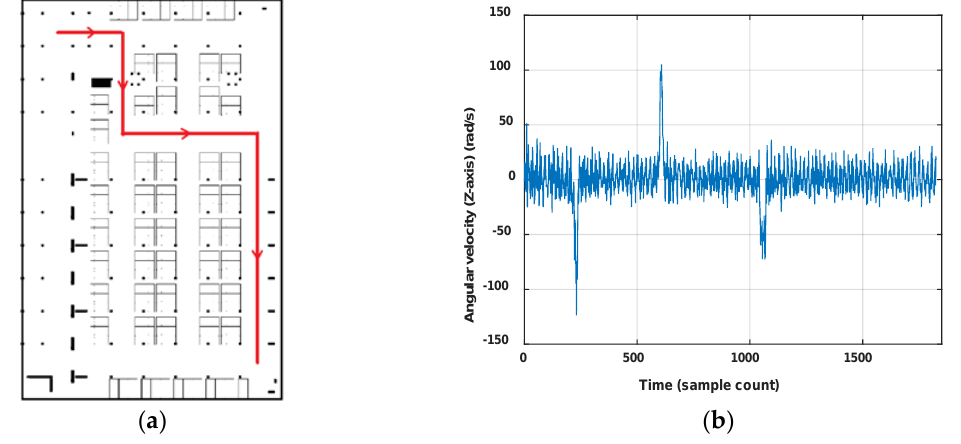
Figure 9. User’s walking trace and the angular velocities measured by a smartphone gyroscope: ( a ) walking trace in an underground parking with three turns; ( b ) angular velocities (vertical component) of the smartphone measured with the walking trace.